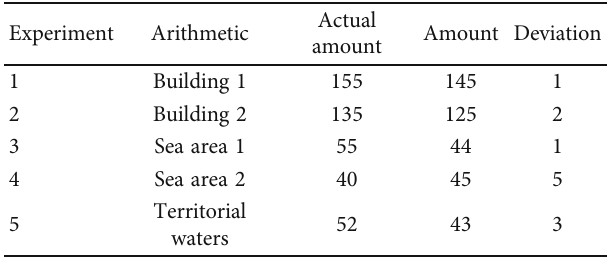
Table 1: Statistics of building extraction results for both algorithms.